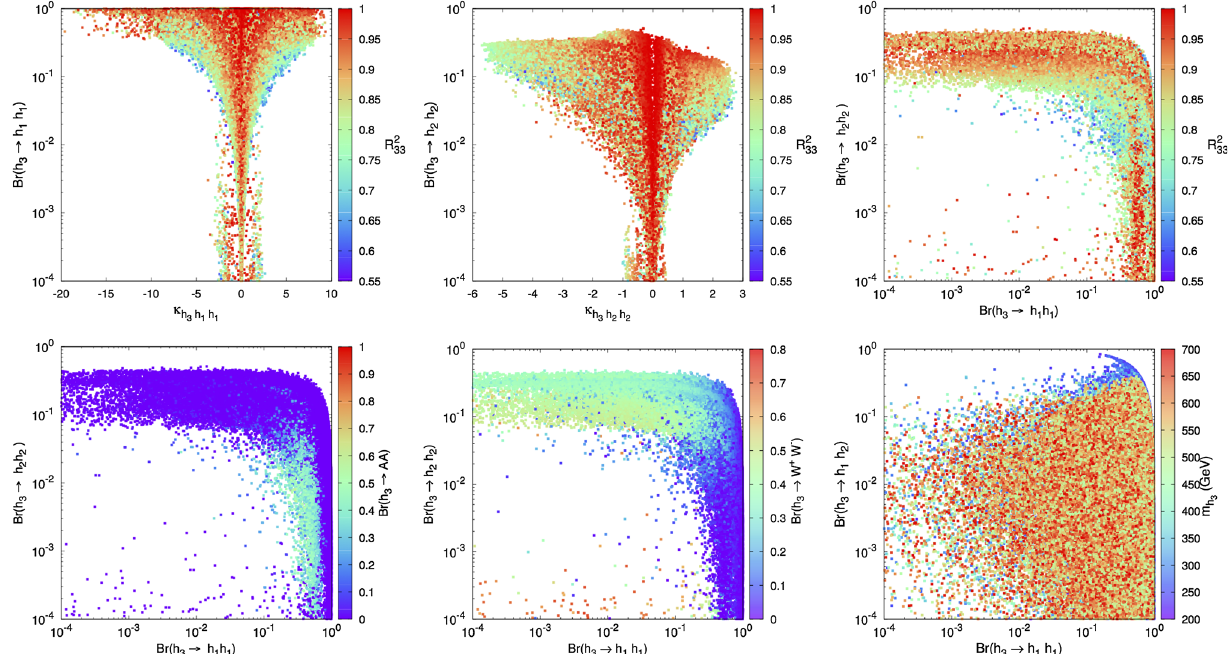
(left) and m h (right) (GeV) in N2HDM type-I 33 3